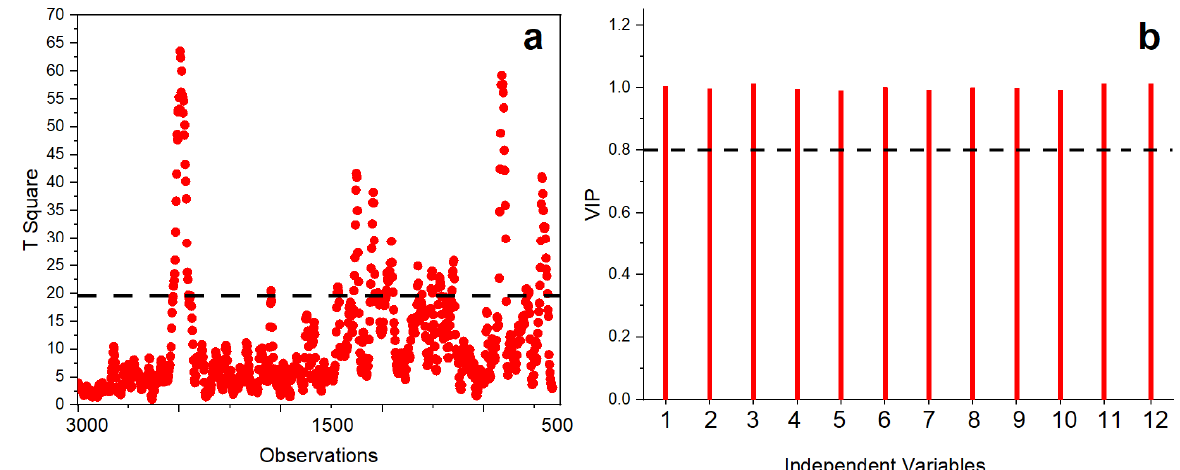
Figure 7. Plots predicted for FT–Raman region ( a ), which could be used to separate oat grains treated with different algae concentrations. VIP values plot for all the analyzed FT–Raman ranges with 0.8 VIP thresholds ( b ), where the numbers stand for the following samples: 0.01 (2); 0.025 (3); 0.05 (4); 0.1 (5); 0.25 (6); 0.5 (7); 1 (8); 2.5 (9); 5 (10); 10 (11); 15 (12).